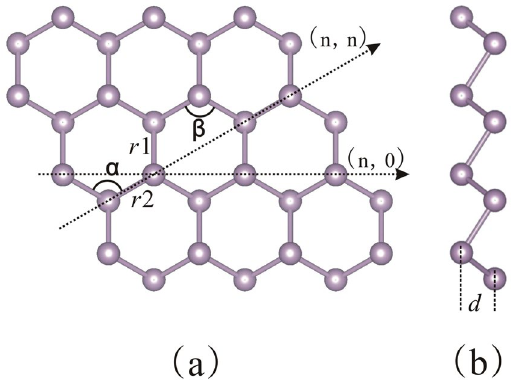
Figure 1. The optimized structure of blue phosphorus monolayer in ( a ) top and ( b ) side views.